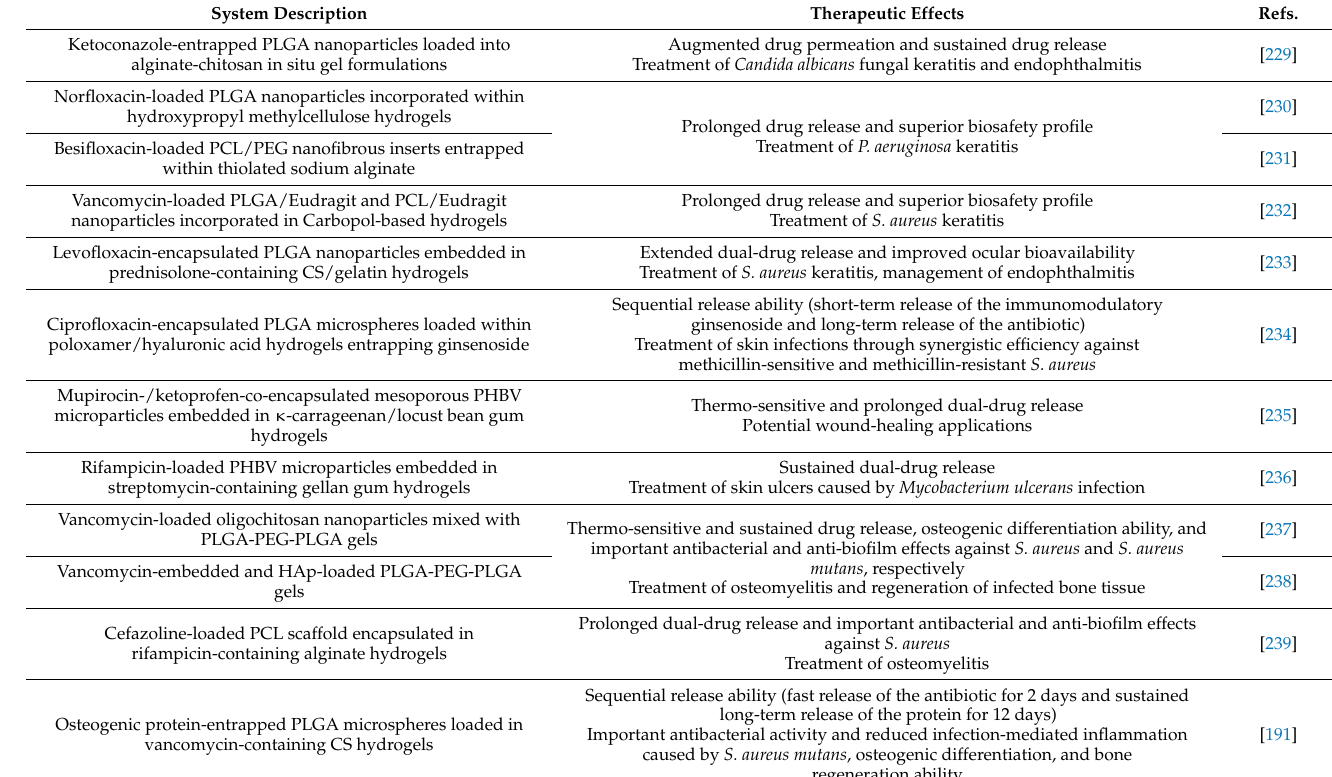
Table 2. Biopolyester-based gel formulations with antimicrobial